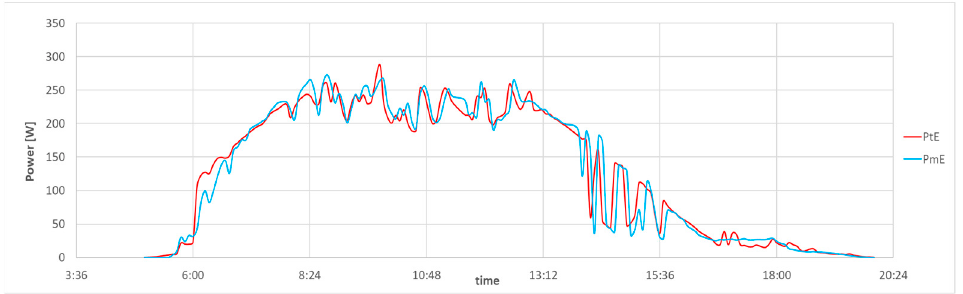
Figure A1. Comparison of simulated and measured power waveforms for PV cells oriented eastward, bearing 110°; PtE—theoretical power, PmE—measured power.